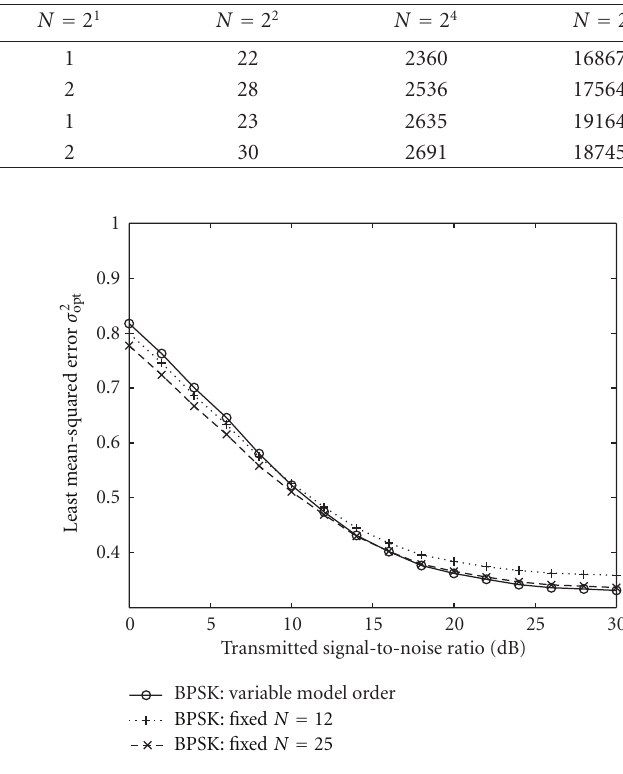
Table 1: Computational complexities of hermitian matrix inversion algorithms in comparison.